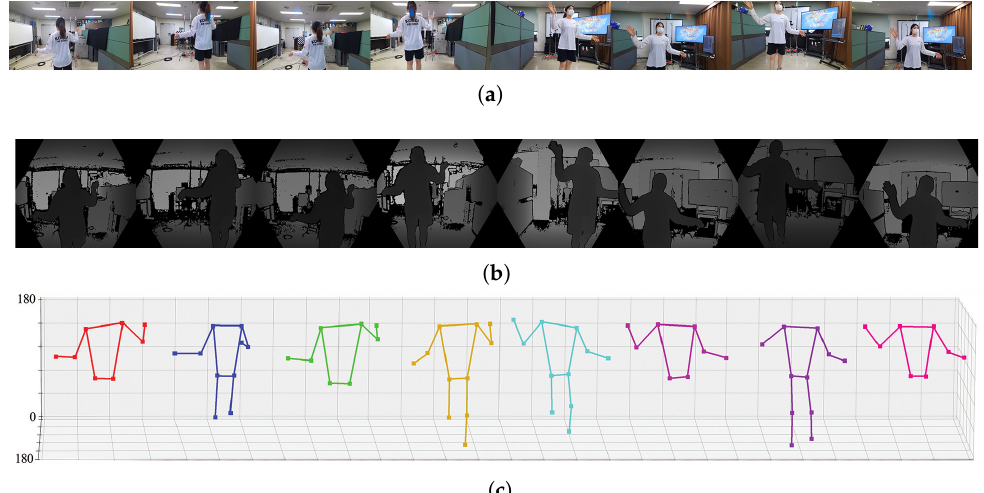
Figure 9. 3D pose estimation result using the deep learning of MediaPipe ( a ) RGB image, ( b ) calibrated depth image, ( c ) estimated joint set in eight